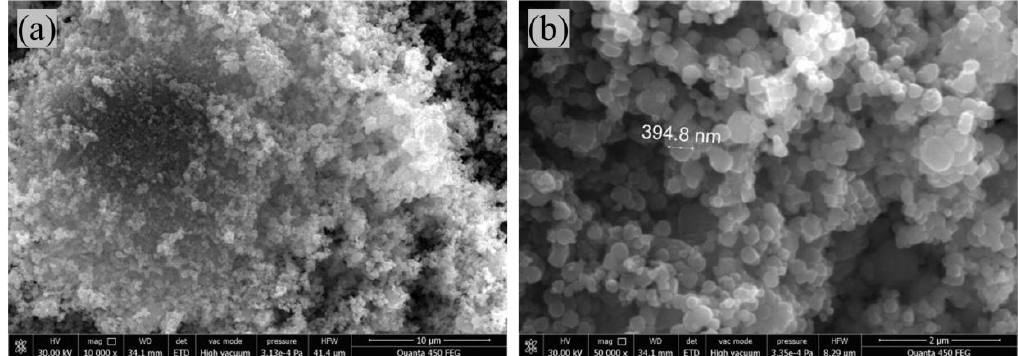
Figure 12. SEM images of Fe 3 O 4 . ( a ) Magnification 30 K; ( b ) Magnification 50 K.